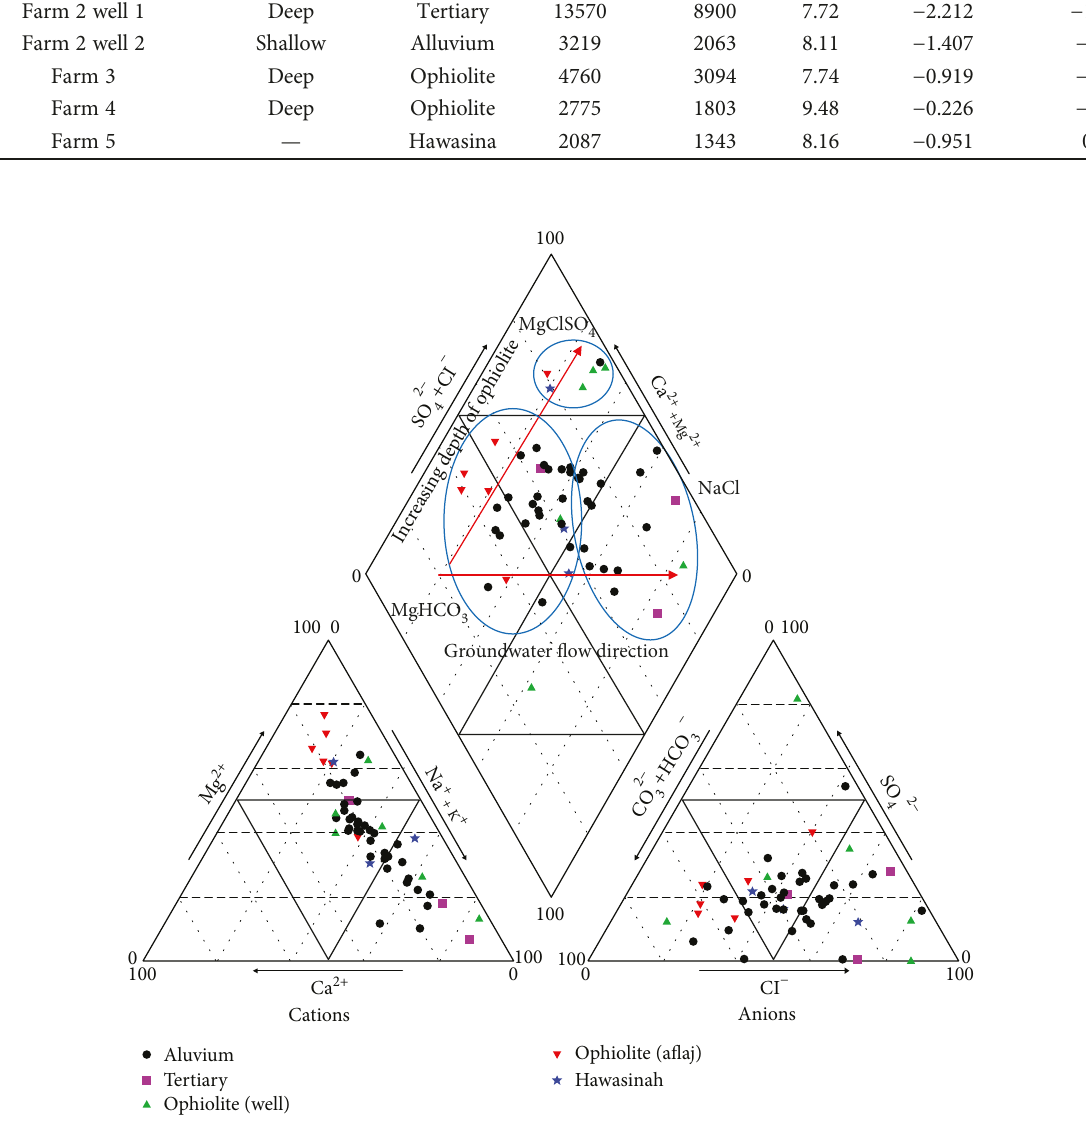
Figure 2: Piper diagram illustrating groundwater classi fi cation in di ff erent geological